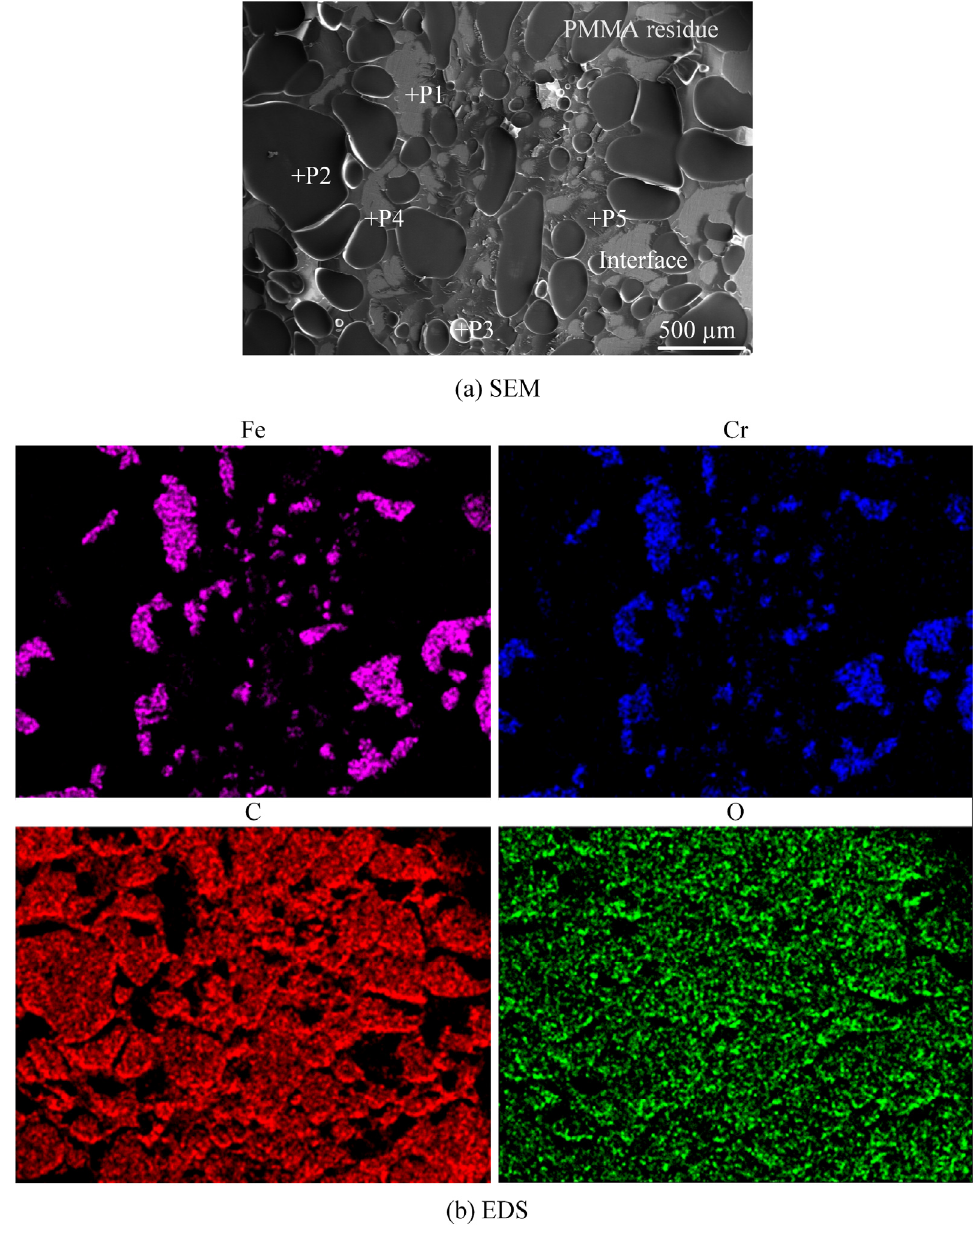
Figure 10. ( a ) SEM image and ( b ) EDS mapping results of the fractured surfaces of the typical sam- ple. Table 4. Chemical compositions (wt%) of representative elements of the analysis points in Figure 10 (a). Position